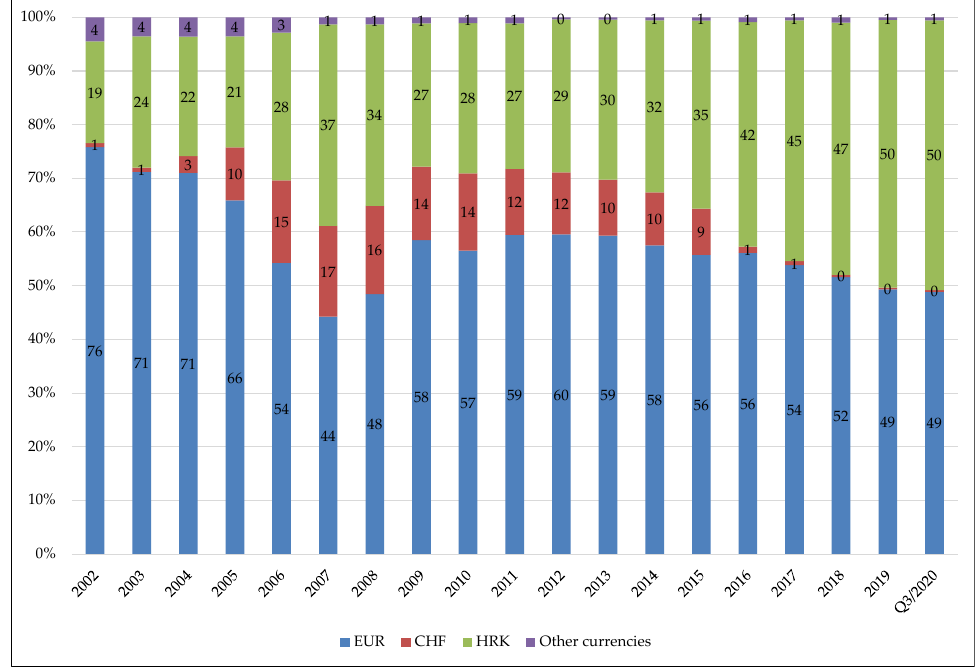
Figure 2. Currency structure of placements in the Croatian banking sector, 2002–Q3/2020. Source: Author’s presentation of the Croatian National Bank (CNB) data, official website, based on excel table e-mp_13–Currency structure of other monetary financial institutions’